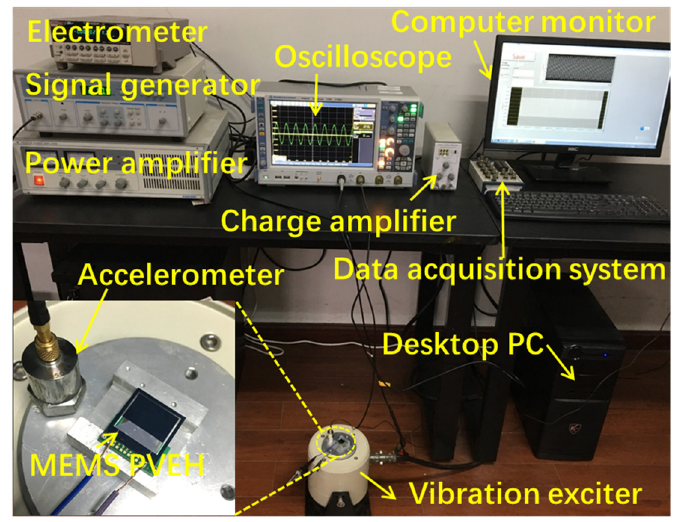
Figure 6. Digital photograph of the experimental setup of testing the device.